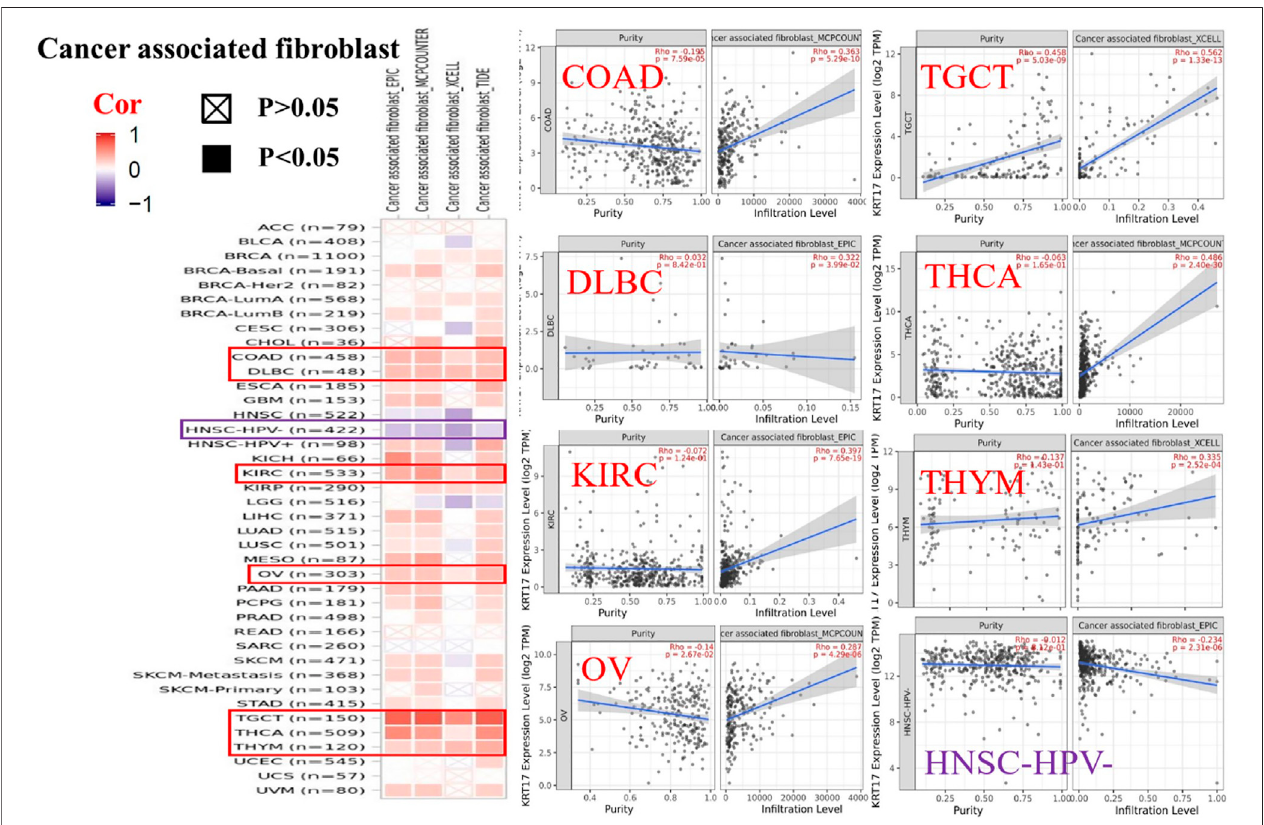
FIGURE 10 | Correlation between KRT17 expression and immune in fi ltration of cancer-associated fi broblasts. In THYM, TGCT, KIRC, COAD, THCA, OV, and DLBC, KRT17 expression was positively correlated with cancer-associated fi broblasts expression; however, in HNSC-HPV-, KRT17 expression was negatively correlated with cancer-associated fi broblast cells (TCGA